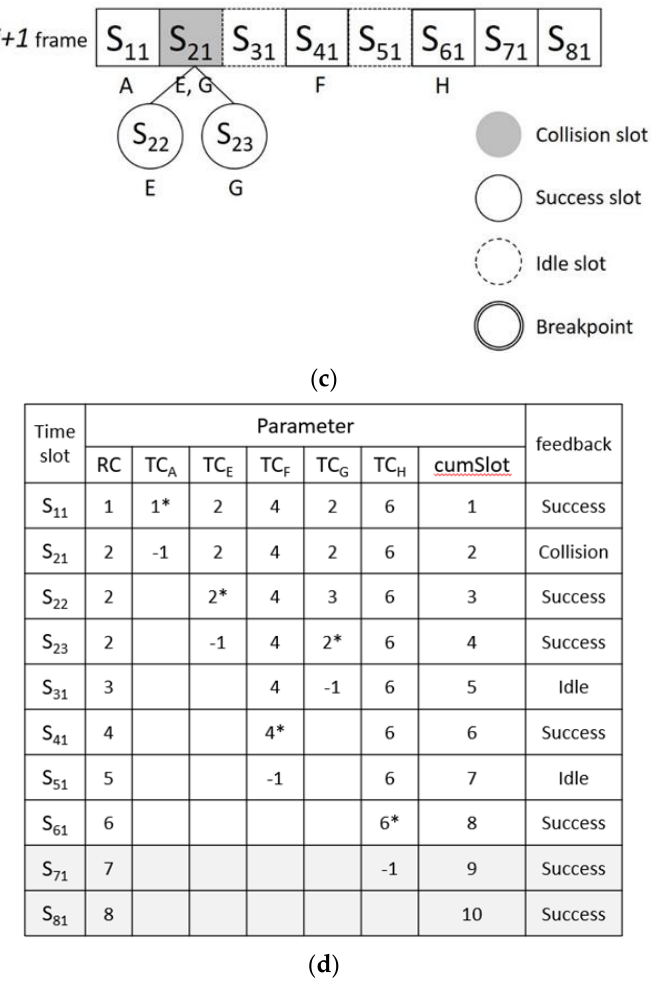
Figure 11 . MABT example: ( a ) frame i ; ( b ) parameters of frame i ; ( c ) frame i + 1 ; and ( d ) parameters of Figure 11. MABT example: ( a ) frame i ; ( b ) parameters of frame i ; ( c ) frame i + 1; and ( d ) parameters of frame i + 1 . frame i +